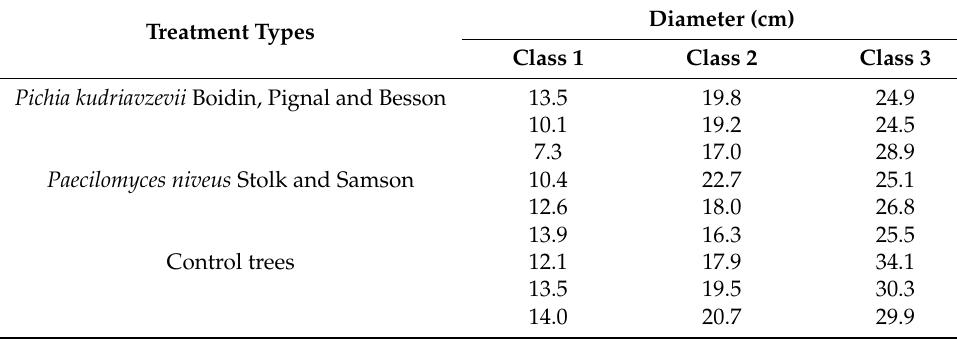
Table 1. Diameter Classes and Treatment Types Divided from Selective Standing Aquilaria malaccensis Lam.,